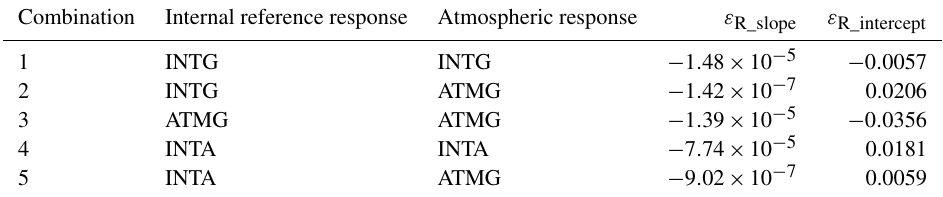
Table 4. Combinations for internal reference and atmospheric response simulation with ε R_slope and ε R_intercept based on Eqs. (18a)–(18b) (Dabas and Huber,